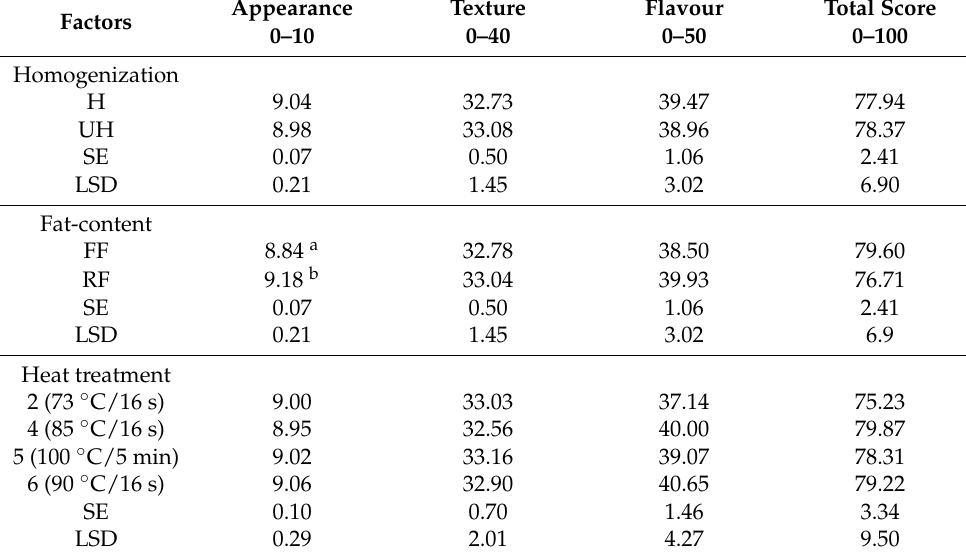
Table 6. Means of organoleptic scores of Quark-type cheeses at 20 d of storage made from unhomog- enized and homogenized full- and reduced-fat milk heated under different conditions. Different letters indicate statistically significant differences (LSD, p < 0.05) in the group of means assigned to each experimental factor. H and UH, homogenized and unhomogenized cheese milk; FF, full fat; RF, reduced fat; SE, standard error; LSD, least significance difference. Appearance Texture Flavour Total Score Factors 0–10 0–40 0–50 0–100 Homogenization H